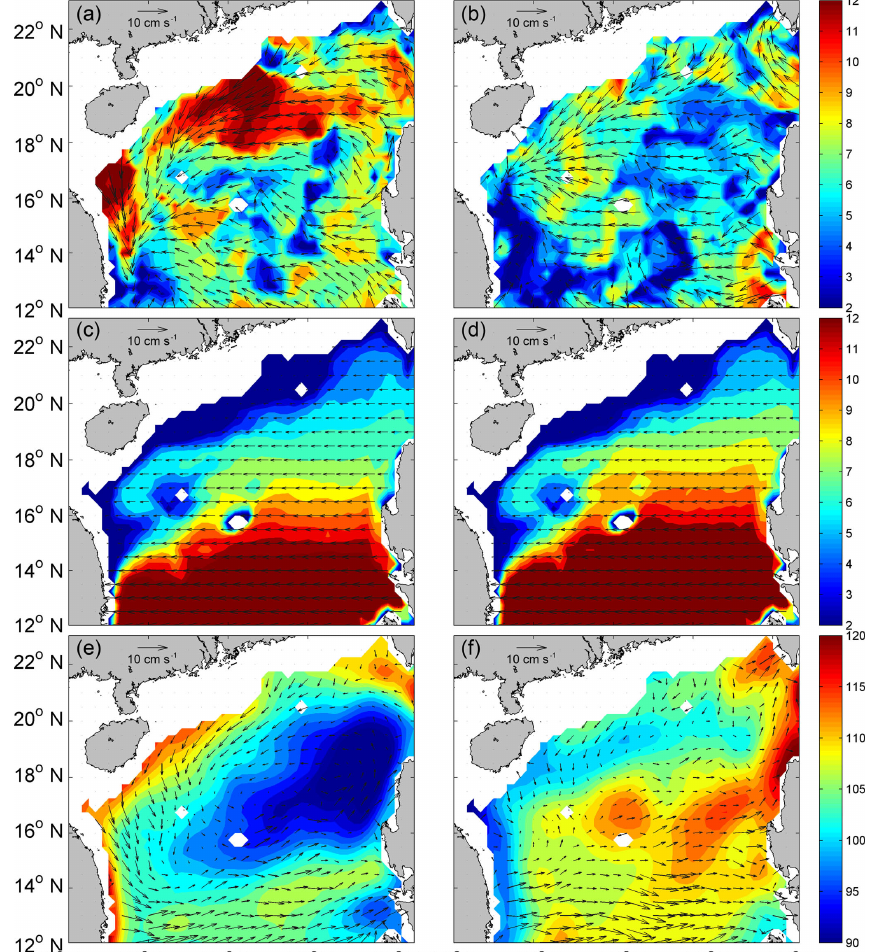
Figure 2. Winter climatology of (a) eddy propagation speed directions (vectors) and magnitudes (color,cms − 1 ). (c) The phase speed direc- tions (vectors) and magnitudes (color, cms − 1 ) of the first baroclinic Rossby wave. (e) The speed difference (vectors) between (a) and (c) su- perimposed on the winter mean absolute dynamic topography (color, cm). (b) , (d) and (f) are the same as (a) , (c) and (e) , respectively, but represent the summer